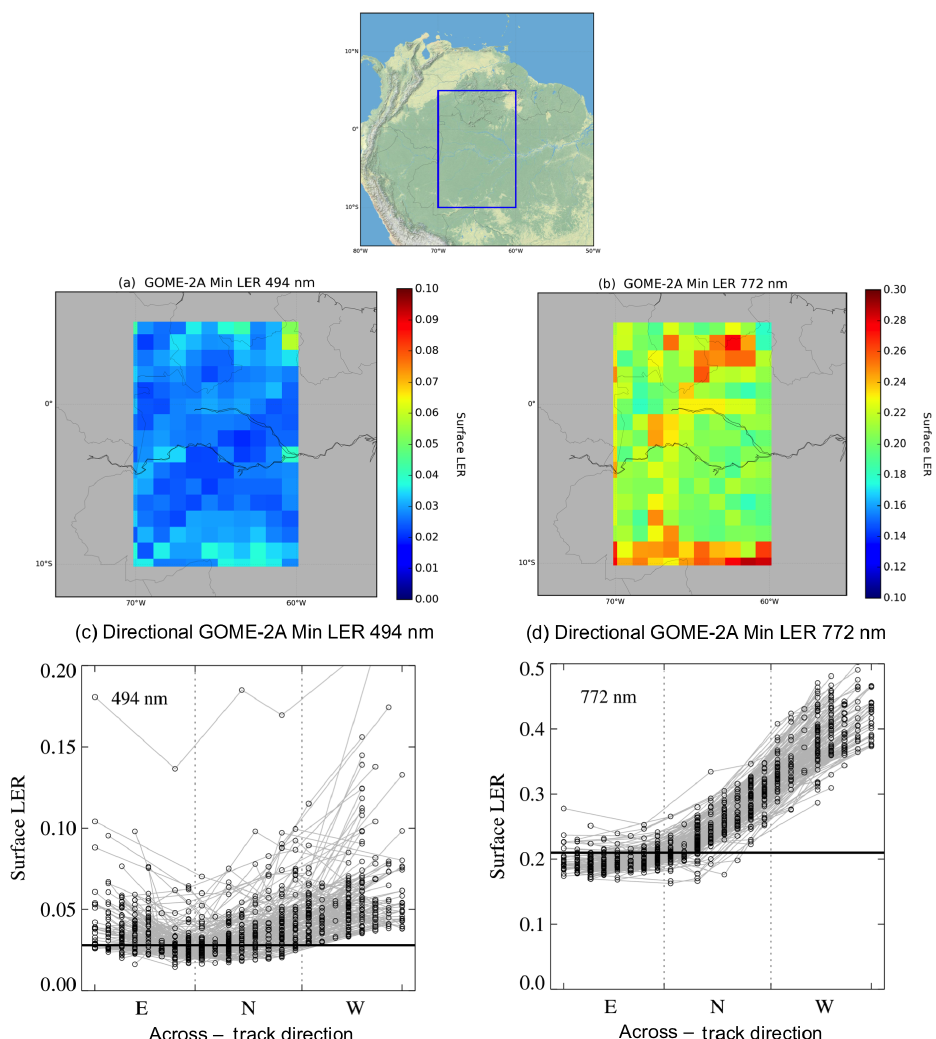
Figure 1. (a, b) Map of GOME-2A minimum surface LER climatology (2007–2013) for March (a) at 494nm and (b) at 772nm over Amazonia (lat: 5 ◦ N–10 ◦ S, long: 60–70 ◦ W, upper panel) at 1 ◦ × 1 ◦ resolution. (c, d) Directional dependence of surface LER climatology (2007–2013) derived from individual measurements along the swath: east (E) for the eight easternmost pixels, nadir (N) for the eight centre pixels and west (W) for the eight westernmost pixels. The horizontal line represents the surface LER using the full swath which is the average of the surface LER in panels (a) and (b)